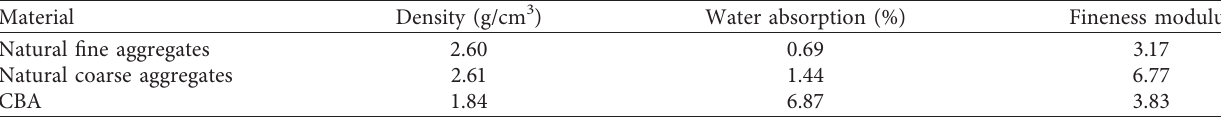
Table 1: Physical properties of the CBA, natural fine, and coarse aggregates.